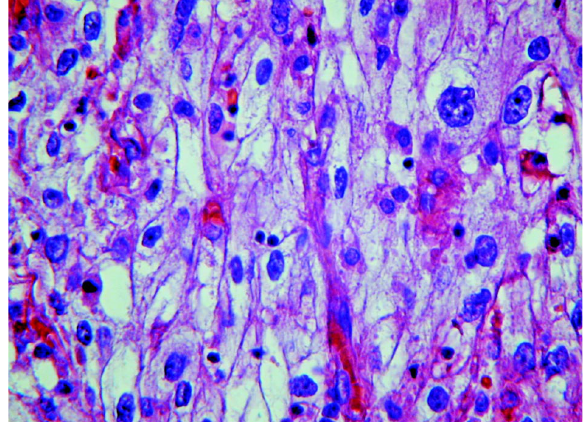
Figure 1 – Photomicrography of sarcomatoid differentiation in clear renal cell